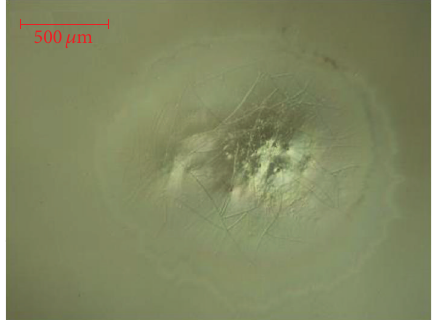
Figure 1: Microscopic image of laser-induced damage owing to contamination on optic